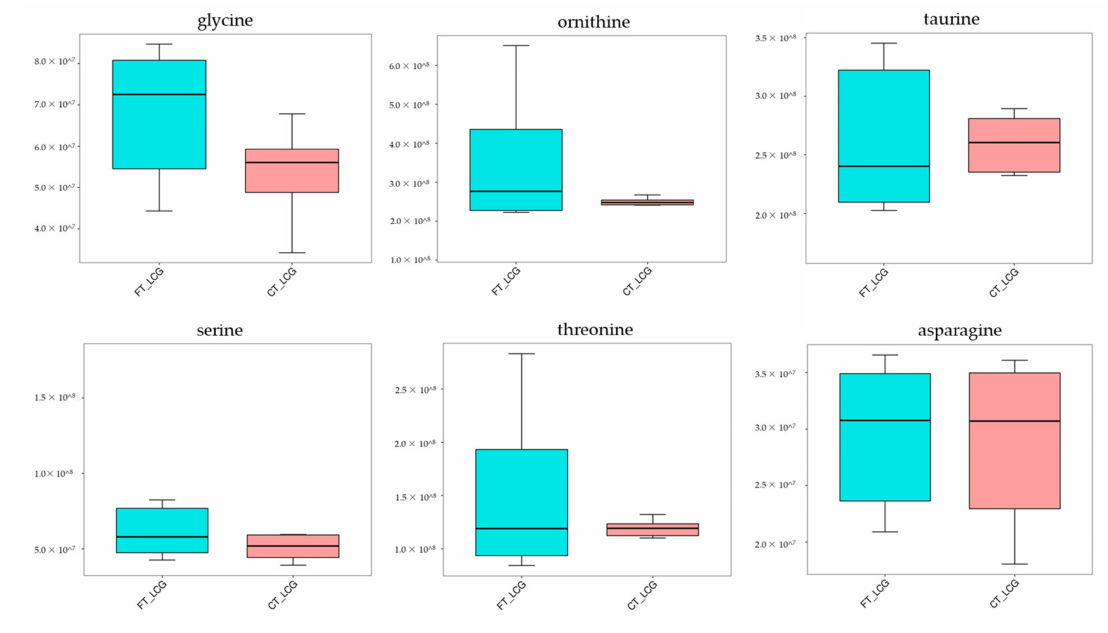
Figure 11. Trend map of relative expression of metabolites.